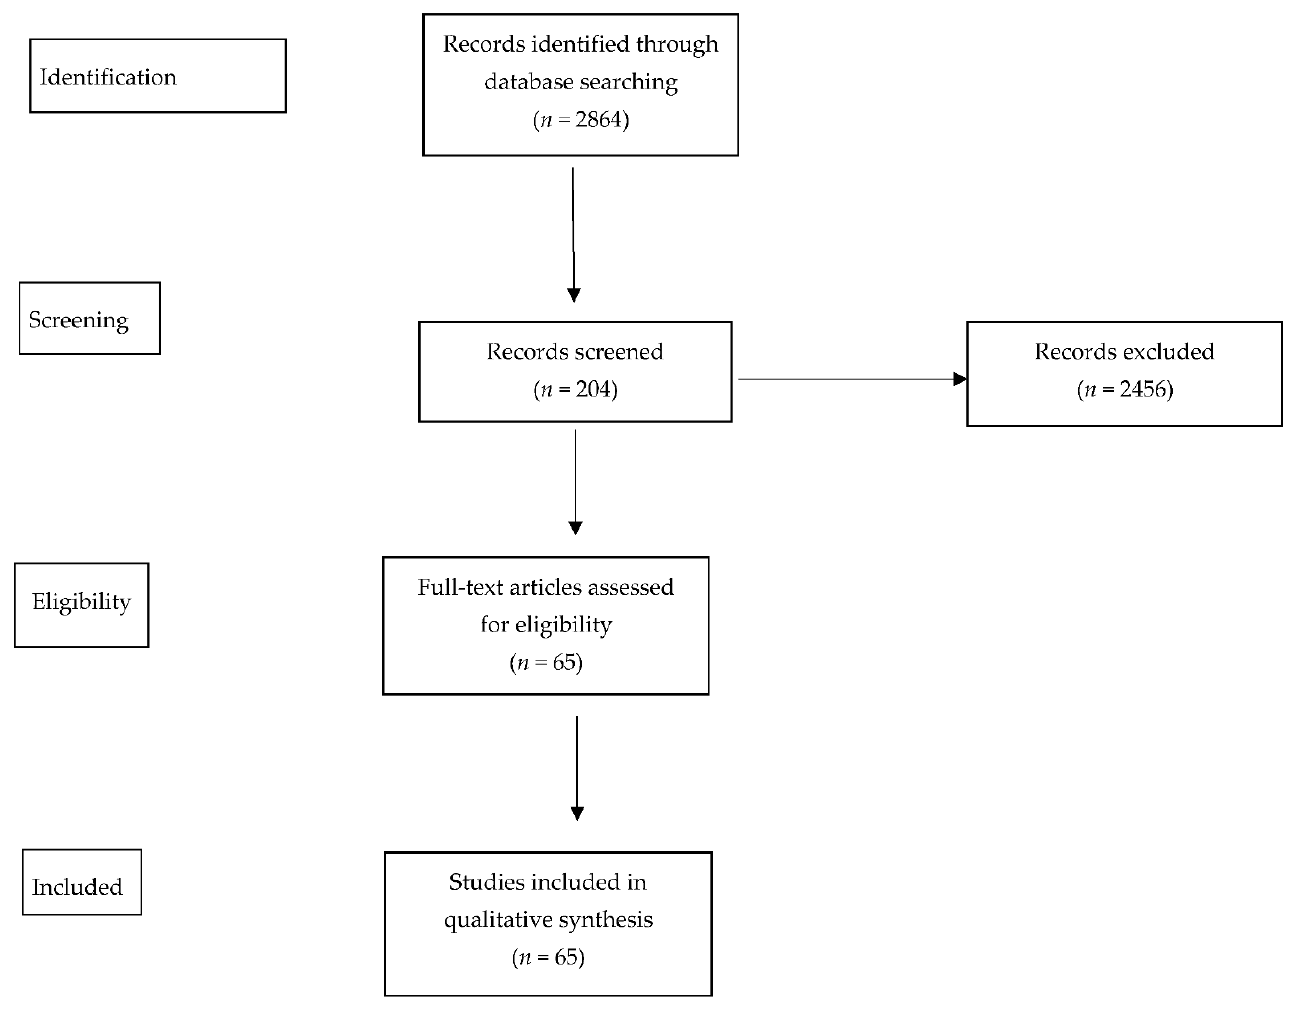
Figure 2. The search